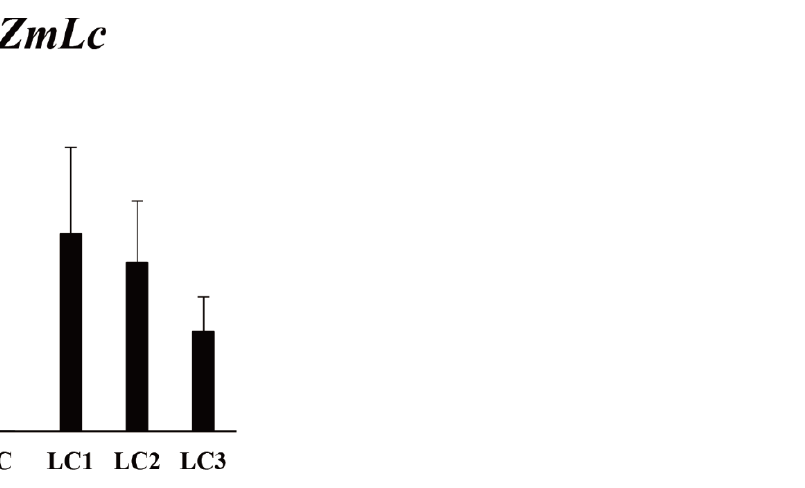
Figure 2. qRT-PCR analysis for ZmLC of GUS - and ZmLC -overexpressing hairy root lines. C: GUS - overexpressing hairy root line; LCn: ZmLC -overexpressing hairy root lines.